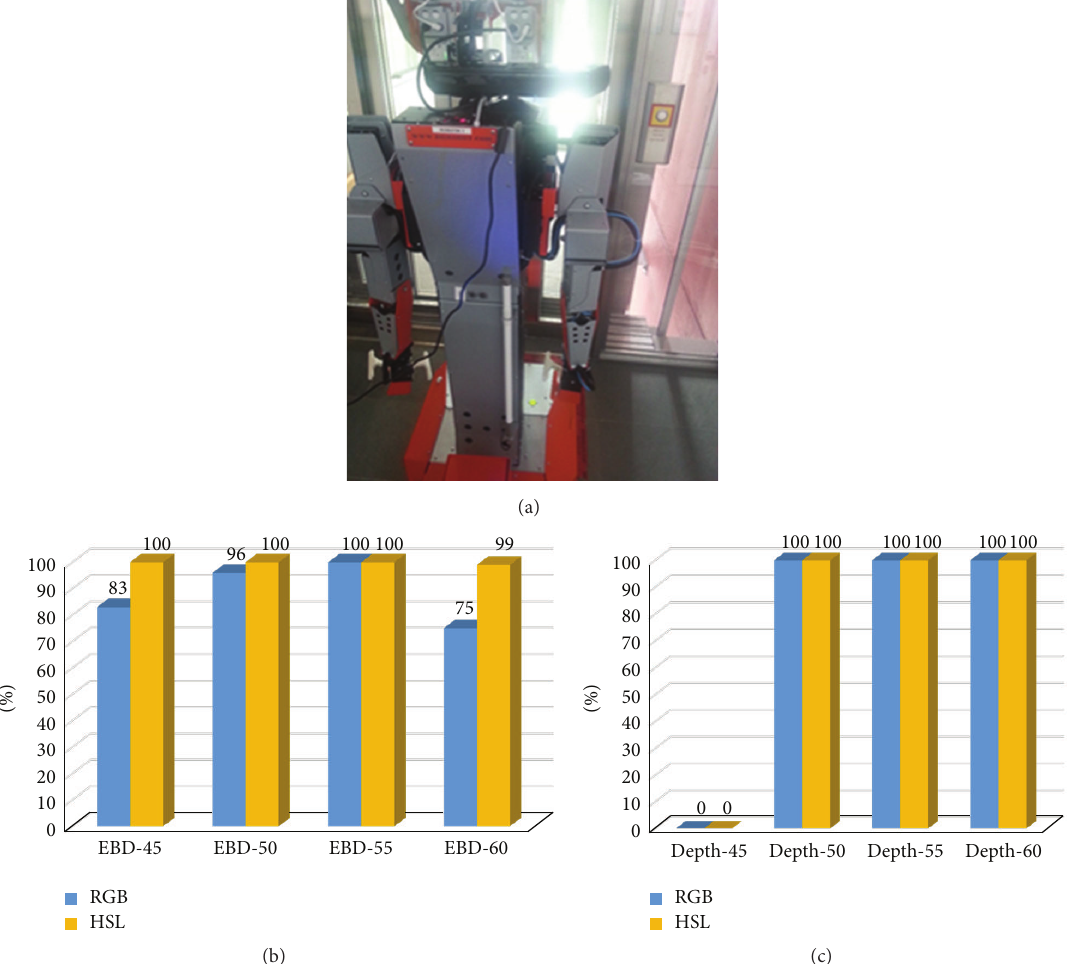
Figure 18: Experiment for elevator entry button detection. (a) Experiment environment for elevator entry button detection. (b) Detection success rate for RGB and HSL module. (c) Depth extraction success rate.